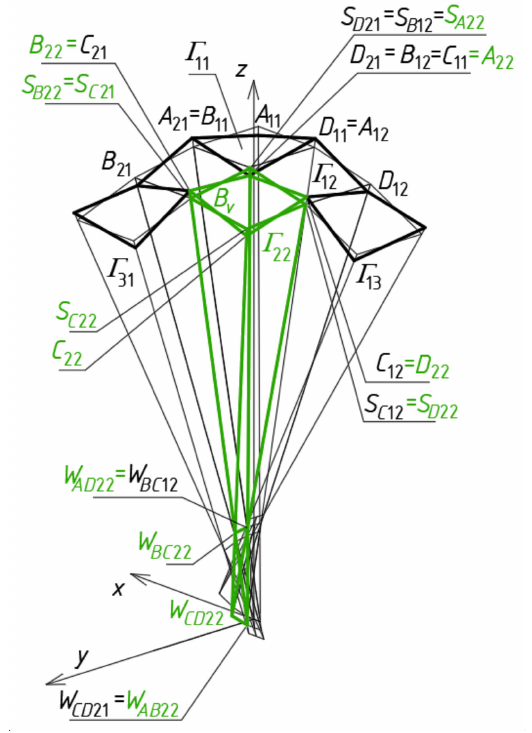
Figure 18. The reference tetrahedron Γ 22 and spatial quadrangle B v 22